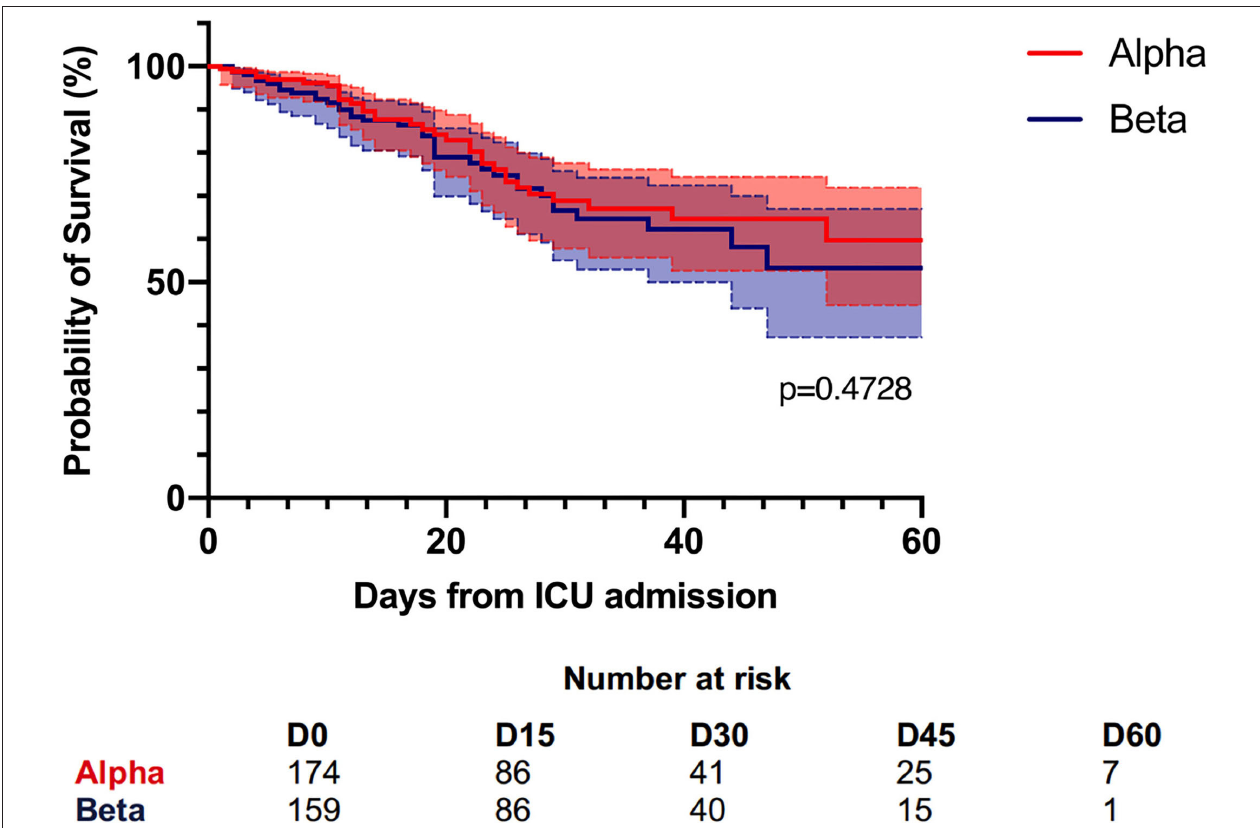
FIGURE 3 | Kaplan-Meier survival curves of the patients who were admitted to an ICU for an infection with Alpha or Beta ( n = 333).